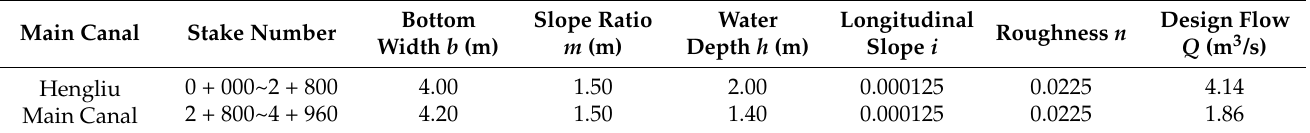
Table 1. Basin information of the Hengliu Main Canal.